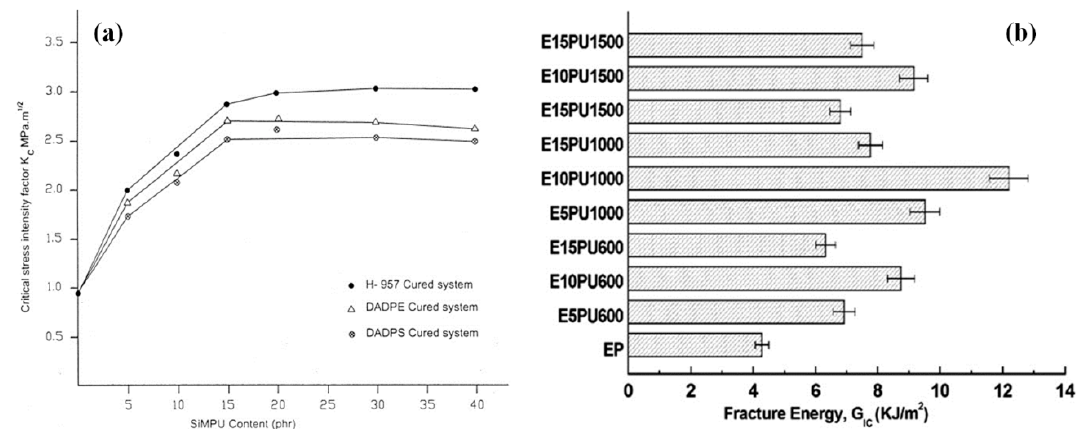
Figure 6. ( a ) Influence of different curing agents (H-957, DADPE and DADPS) on the stress intensity factor, K C of modified epoxy systems. Reprinted with permission from ref. [11], Copyright [2003], John Wiley and Sons. ( b ) Fracture energy of PU modified epoxy systems obtained with various molecular weights (600–1500 g·mol − 1 ) of polyethylene glycol. Reprinted with permission from ref. [57], Copyright [2014], John Wiley and Sons.